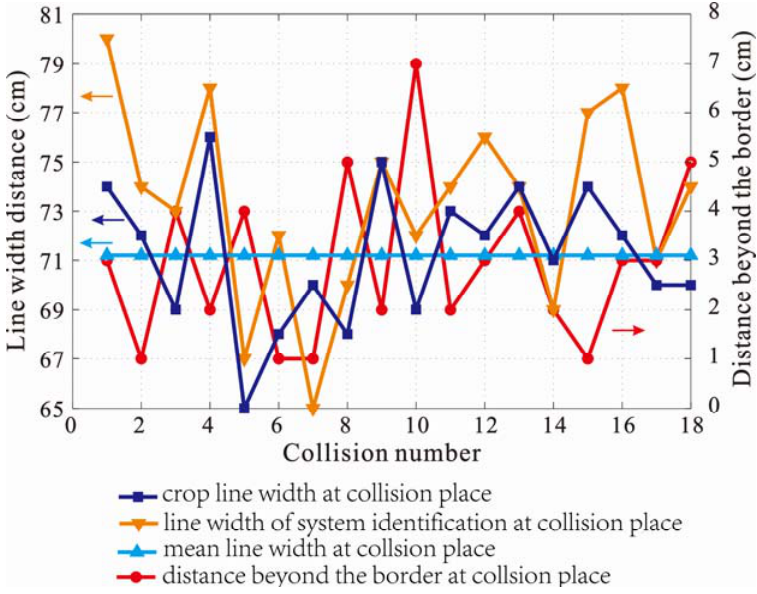
Figure 14. The stalk width and identification width of the collision position.